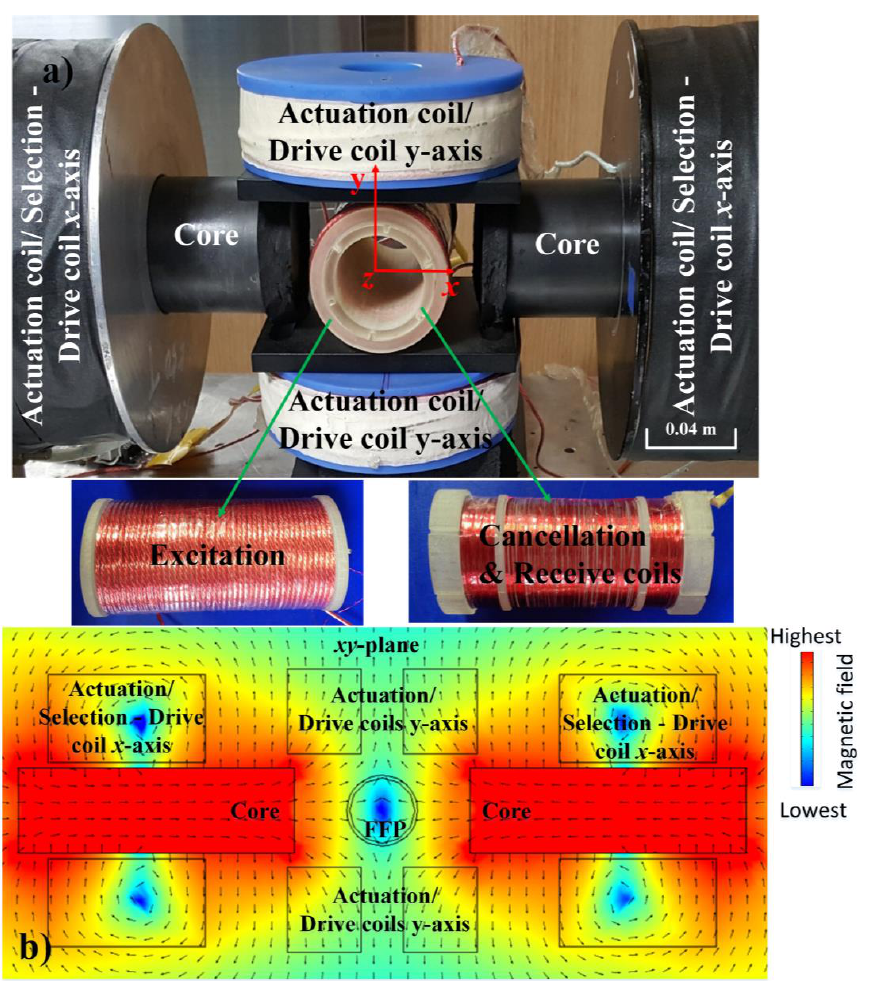
Figure 2. Experimental setup for two-dimensional (2D) navigation of MNPs. ( a ) Coil configuration setup in the 2D navigation system experiment. ( b ) Animation of FFP used for 2D magnetic particle imaging (MPI) signal generation is illustrated in the x - y plane. The color and length of the cones represent the magnitude of the field, while the direction of the cones indicates the field direction.